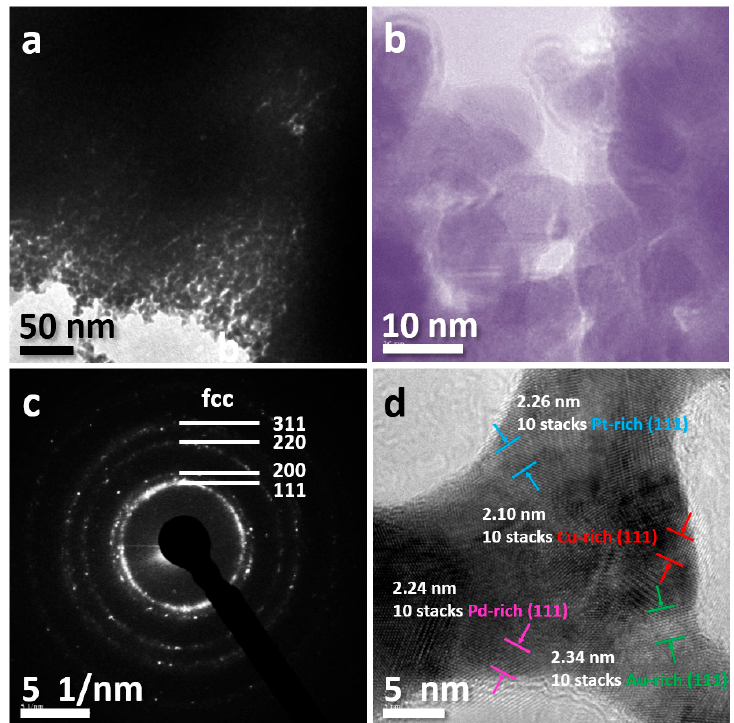
Figure 7. TEM image ( a ), corresponding SAED patterns ( b ), magnified TEM image ( c ), and high-resolution TEM image ( d ) of the dealloyed porous microspheres.